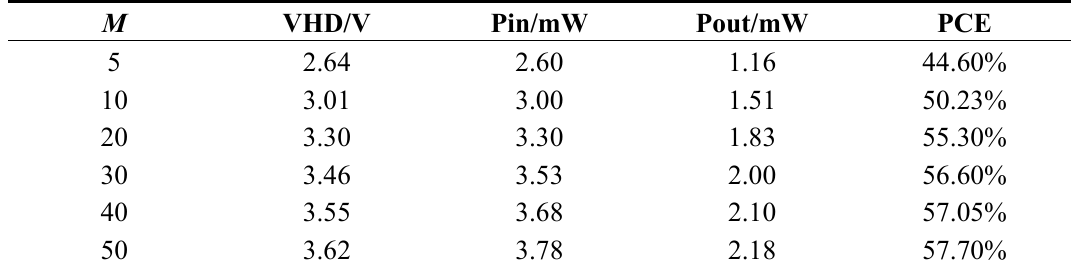
Table 1. Simulation results of NMOS gate cross-connected bridge rectifier ( R = 6 V).